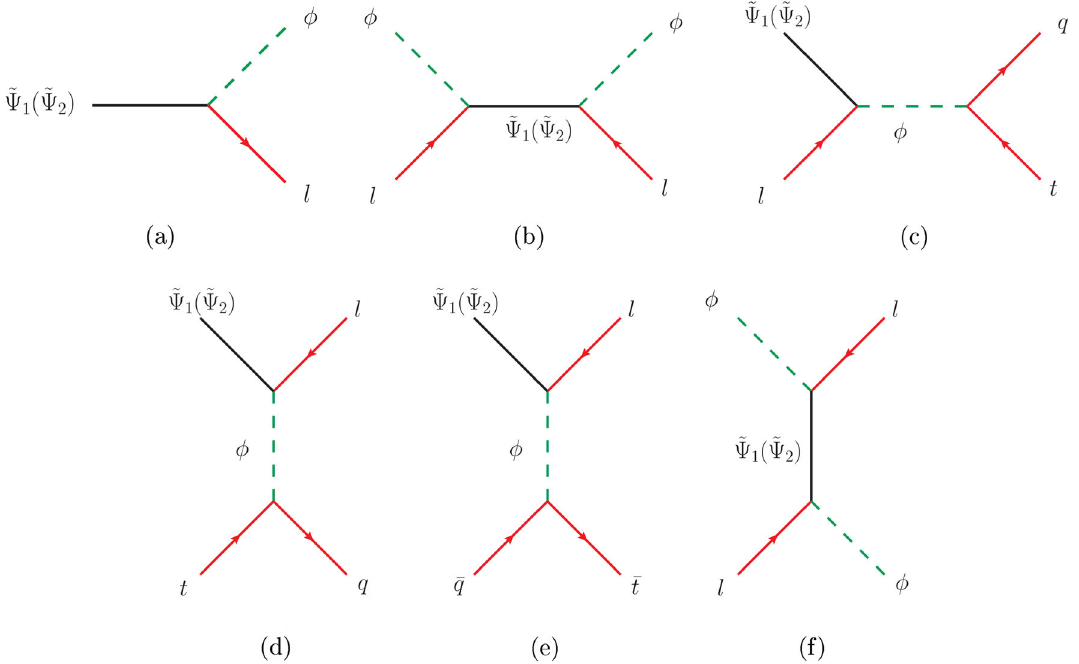
,γ 2 (cid:12) L = 1, t -channel φ, s ), d , e s ,γ 2 (cid:12) L = 2, t -channel φ, t ), f t t